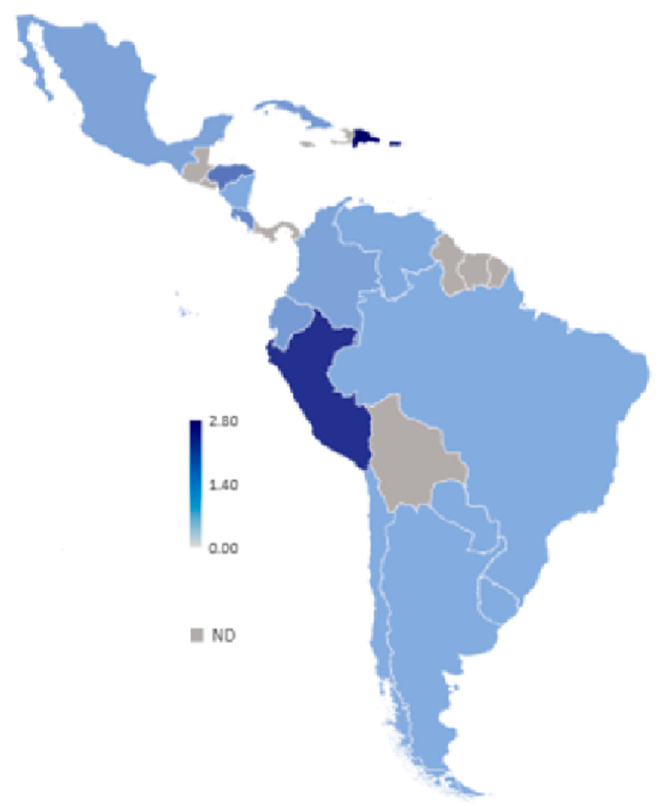
Figure 6. HTLV prevalence. Numeric values are in percentage. ND: not determined.